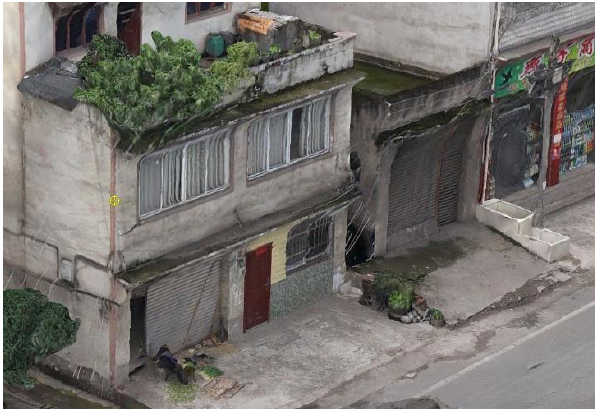
Figure 6. Model structure deformation